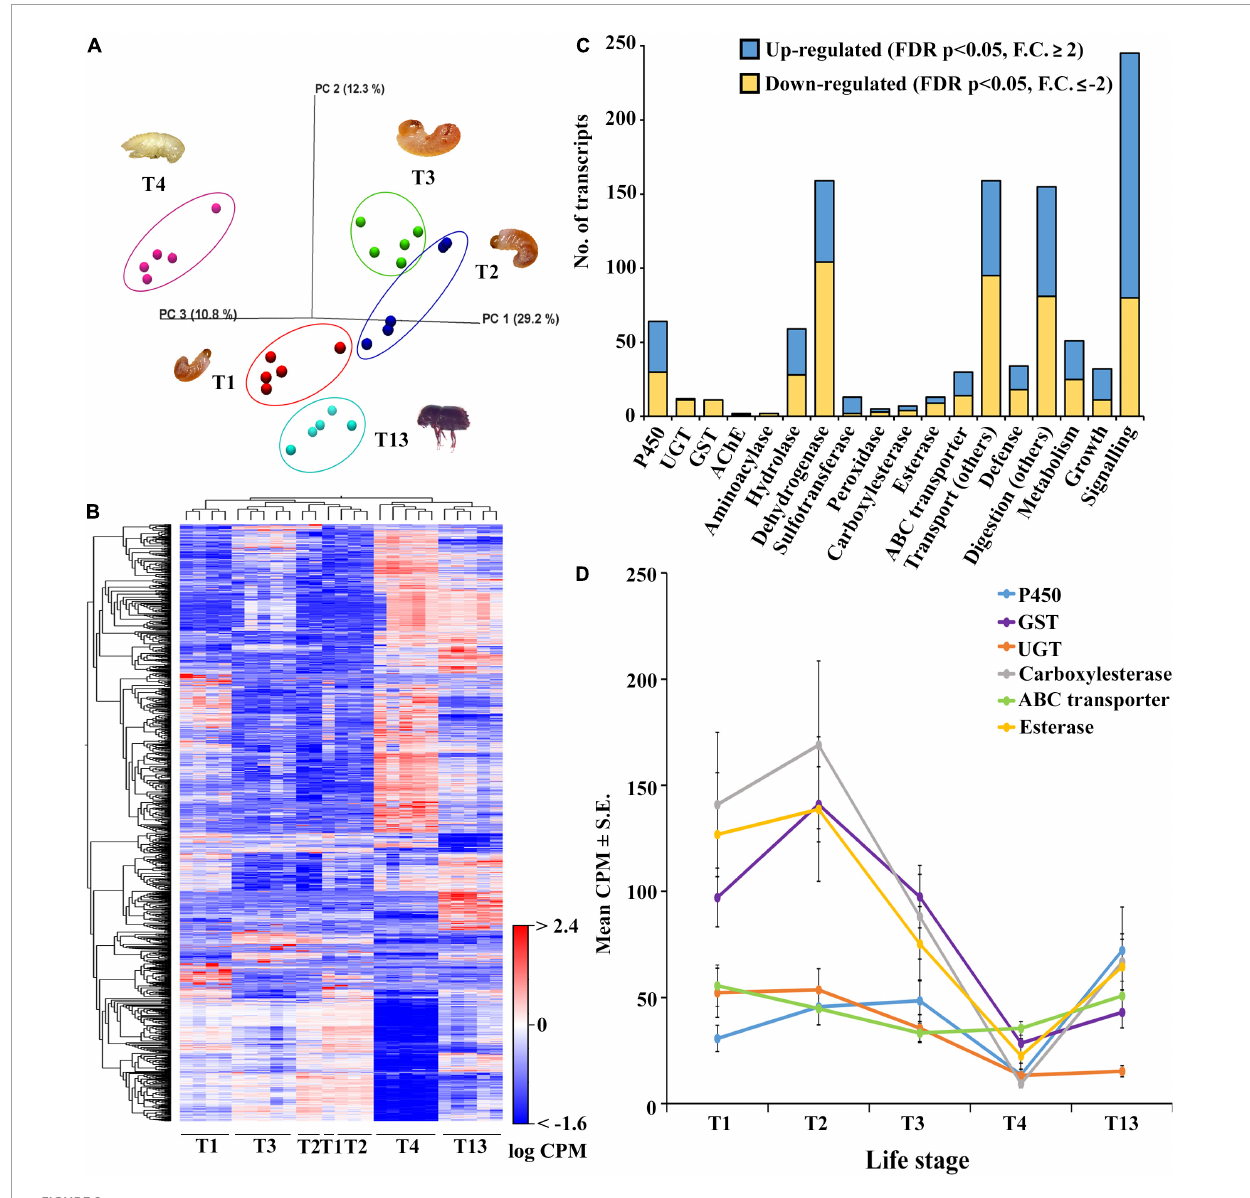
FIGURE2 Group-wise comparison between different developmental life stages; larvae 1-3 (T1-T3), pupae (T4), and sclerotized adult whole body (T13) ( N = 5). (A) PCA plot showing sample clustering. (B) Heat maps representing gene clustering. The color spectrum, stretching from blue to red, represents TMM-adjusted log CPM expression values obtained after DGE analysis. (C) Bar graphs showing the number of transcripts (CPM) for differentially expressed contigs of specific detoxification-related enzyme families and other essential enzymes related to defense, digestion, transport, metabolism, signaling, and growth after group-wise comparison between different developmental life stages. (D) Detoxification enzyme dynamics during different life stages. Average CPM ± standard error values of significantly expressed genes are plotted against each enzyme on the x -axis corresponding to the life stages on the y -axis. The total CPM was calculated by taking the average of all the differentially expressed contigs of each gene family. Analysis was done using CLC workbench (21.0.5, Qiagen, Denmark) with FDR p < 0.05 and a fold change ± 2 cut-off.